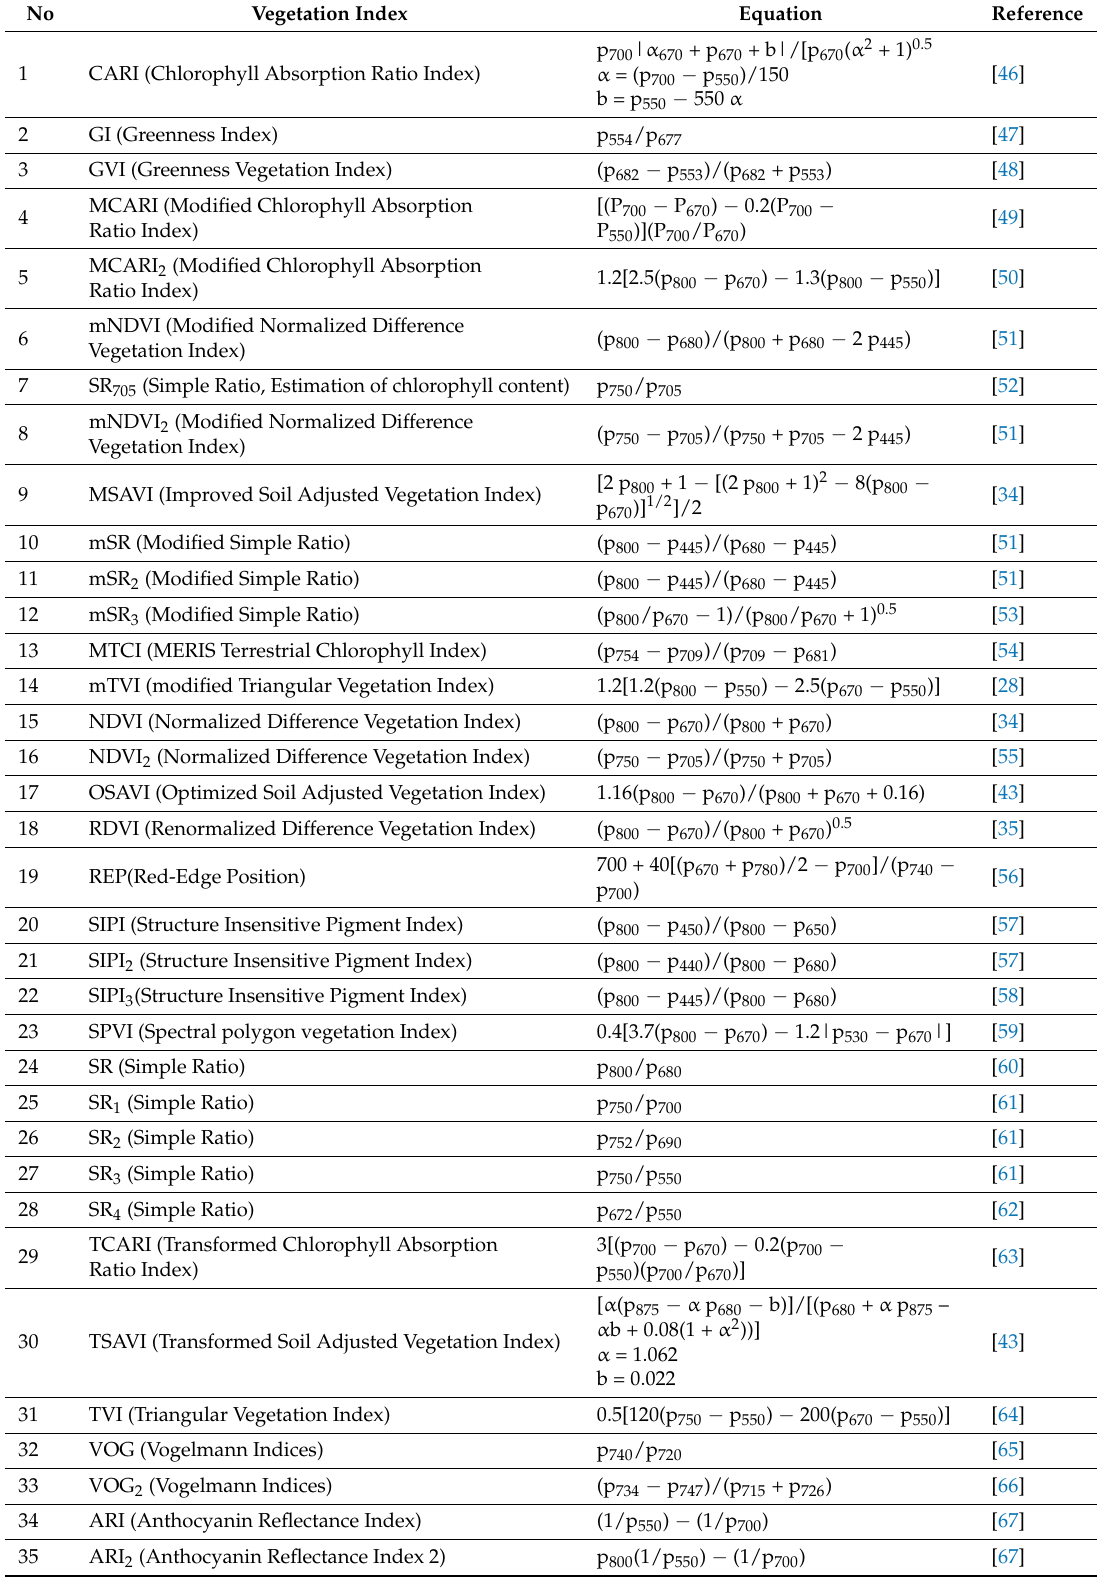
Table 2. Hyperspectral vegetation indices used in the